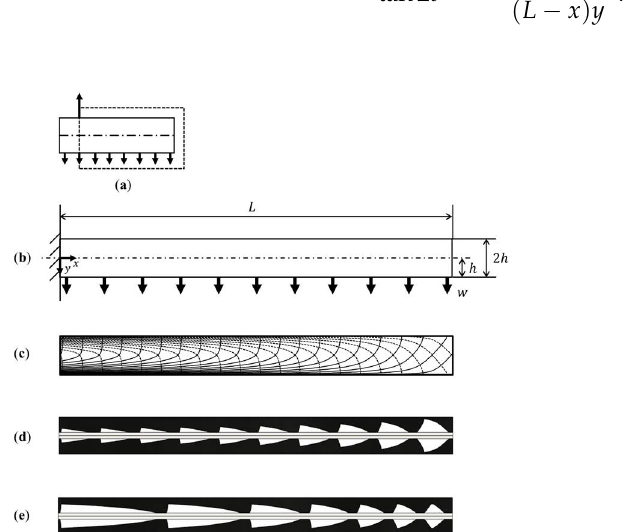
Figure 5. Beam design using principal stress lines. A part of the device is modeled as a cantilever ( a ) Based on the cantilever model ( b ), principal stress lines are derived ( c ). Solid and dashed lines correspond to compressive and tensile stress, respectively. We design the structures of the device using principal stress lines with uniform pitch ( d ) and uniform bottom thickness ( e ).